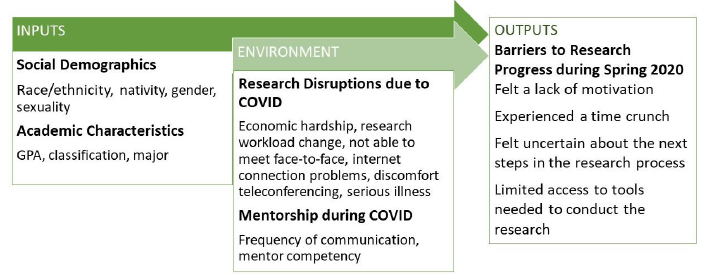
Figure 1. Input–environment–output (IEO)